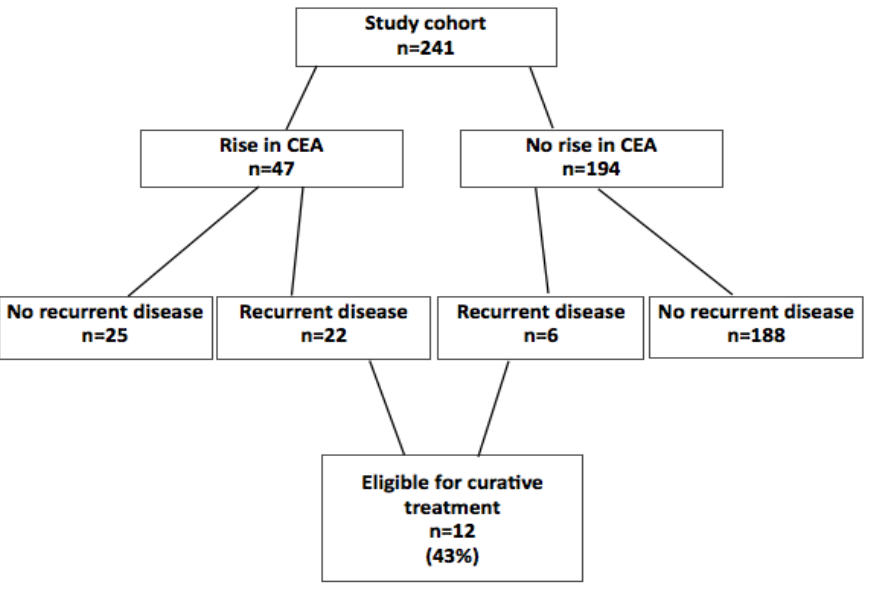
Figure 1. Results from the phase II